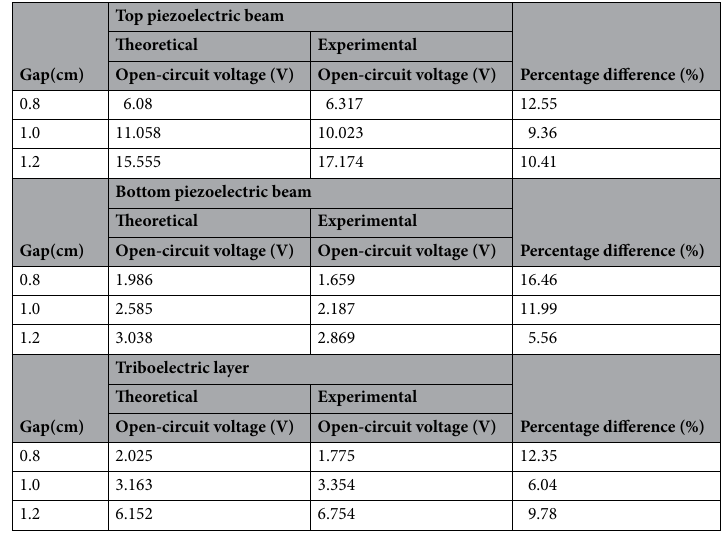
Table 4. Theoretical and experimental voltages from the top piezoelectric beam, bottom piezoelectric beam, and triboelectric mechanism under different magnetic stiffnesses.